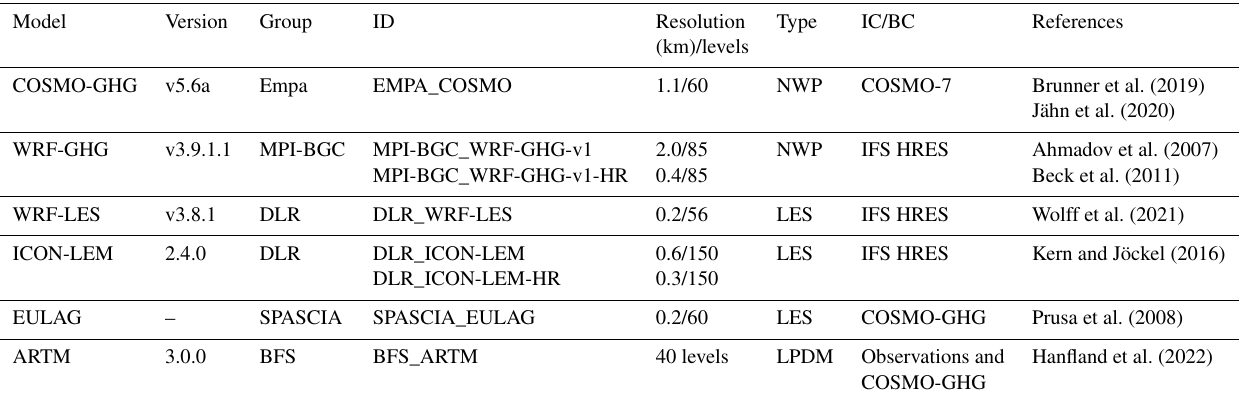
Table 3. Overview of participating model systems. The model version is the version of the meteorological core (COSMO, WRF, and ICON). The ID is the identifier used to distinguish between different model systems and simulations. The column “IC/BC” denotes the source of the meteorological data used as initial and boundary conditions. The models WRF-GHG, ICON-LEM, and WRF-LES were run in configurations with multiple nests, in which case the column “IC/BC” describes the initial and boundary conditions for the outermost domain. Note: LPDM is the Lagrangian particle dispersion model, and HRES is high